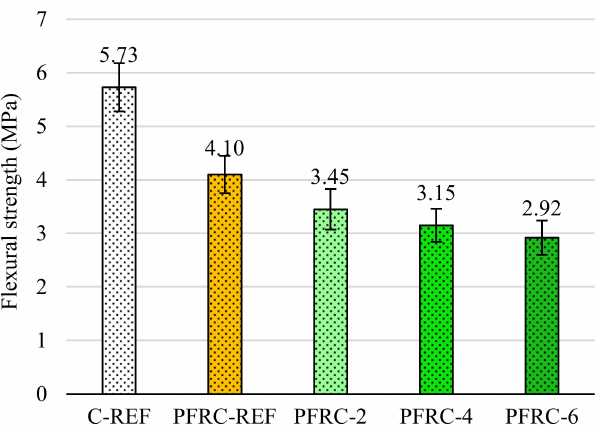
Figure 4. Flexural strength values for all mixtures, along with the standard deviation bands.